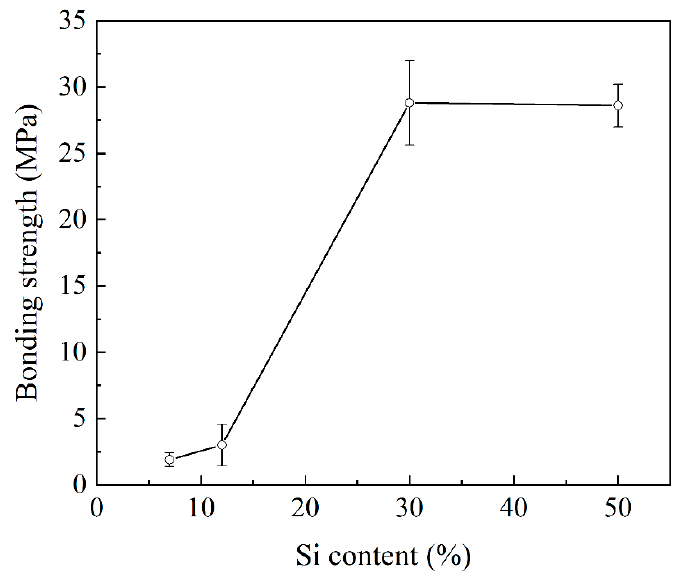
Figure 4. Plot showing the effect of Si content on the bonding strength of the Al/SiC joint (error bar represents standard deviation in tested samples).